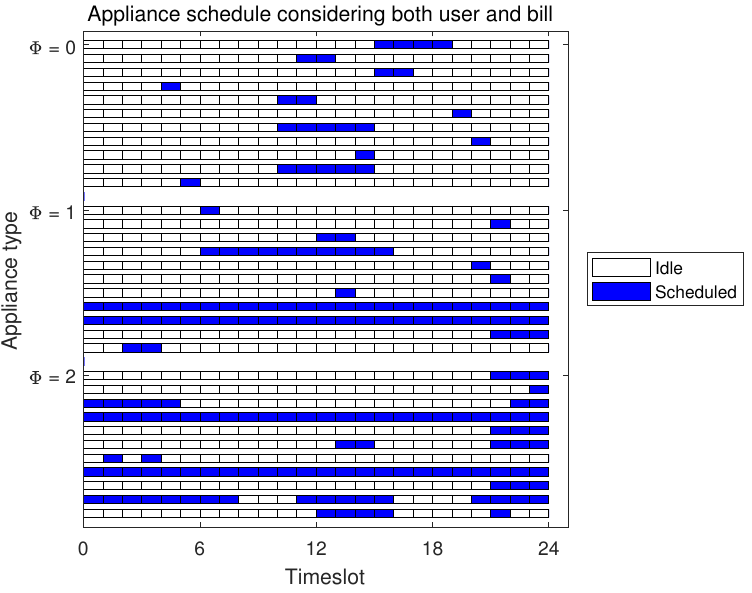
Figure 13. Scheduling results of appliance vs. timeslot if considering both the electricity bill and the preferred time.